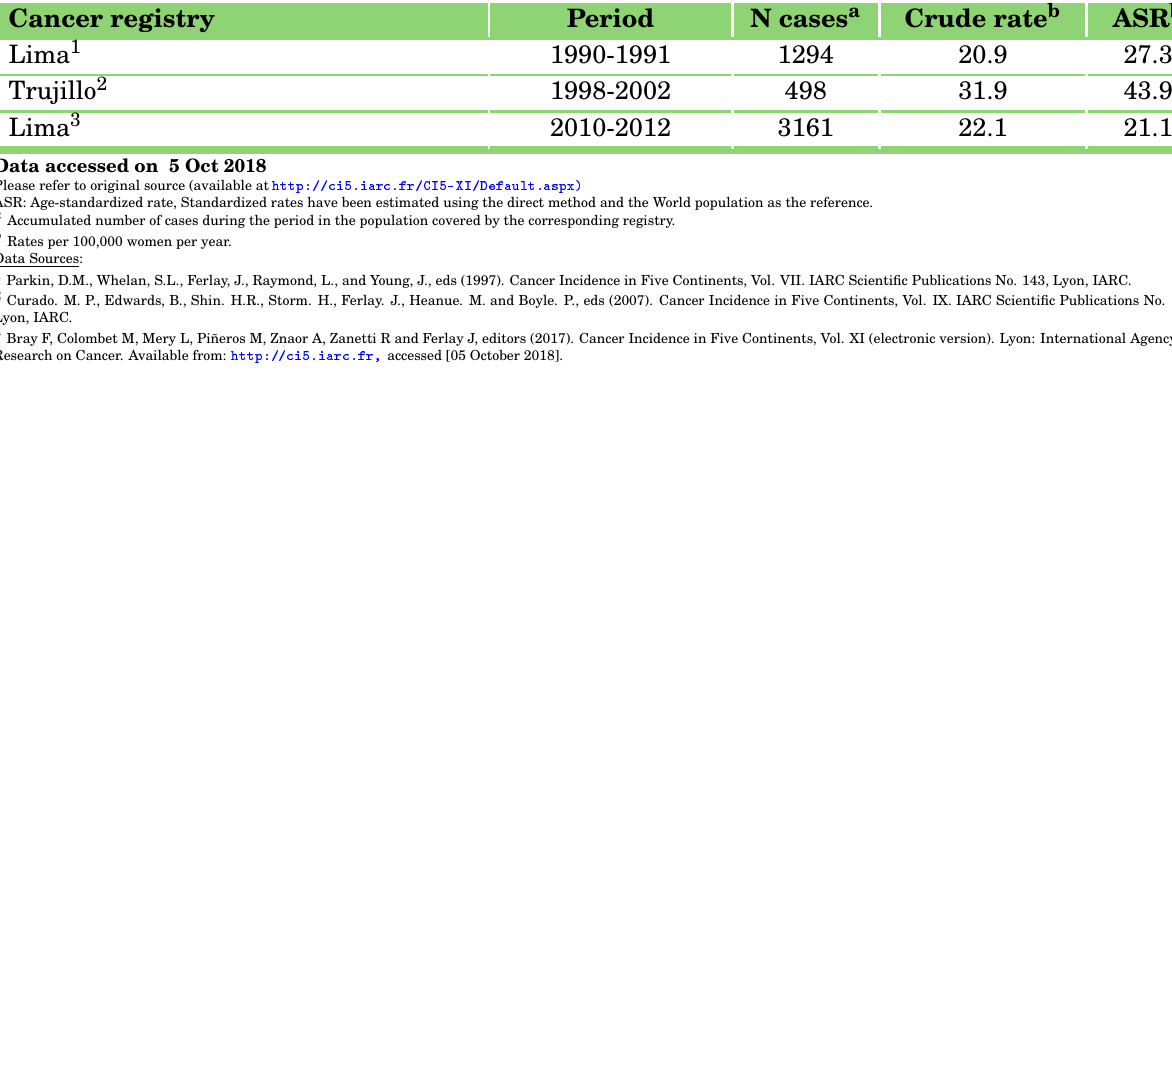
Table 3: Cervical cancer incidence in Peru by cancer